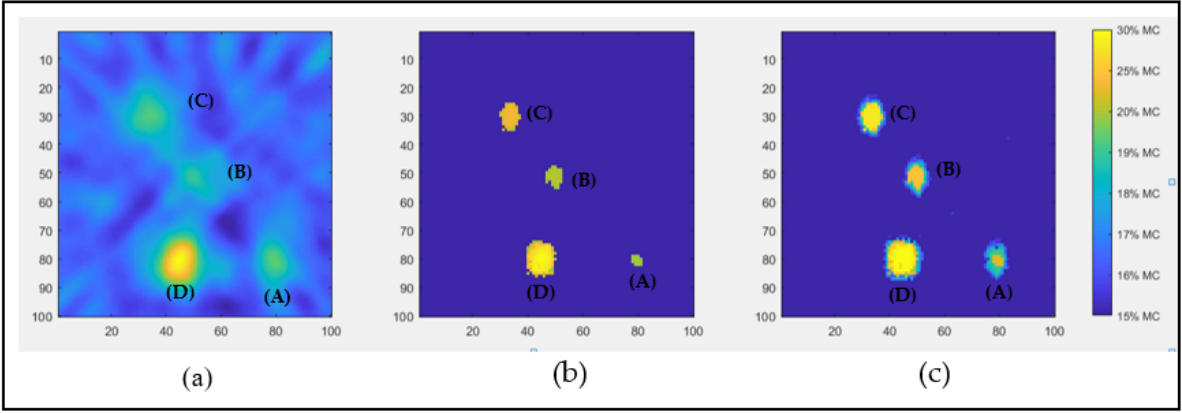
Figure 5. The attenuation image was reconstructed using ( a ) Tikhonov and ( b ) LASSO and ( c ) Hybrid Tikhonov–LASSO (HTL).